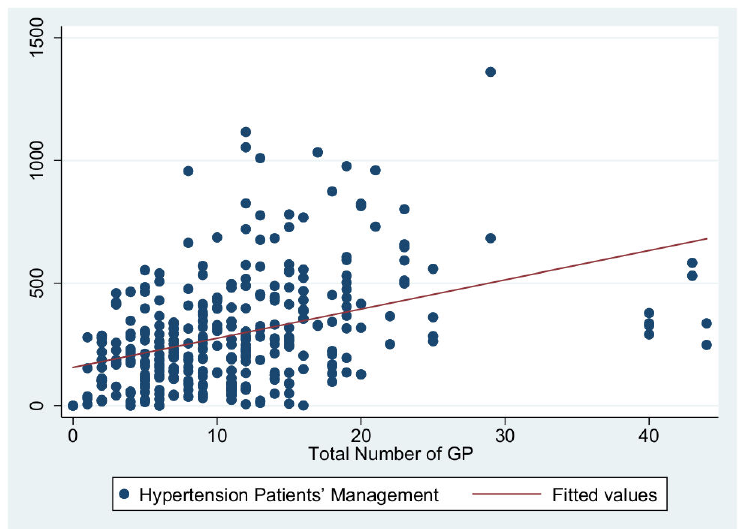
Figure 1. Scatter diagram of hypertension patient management and total number of GPs.